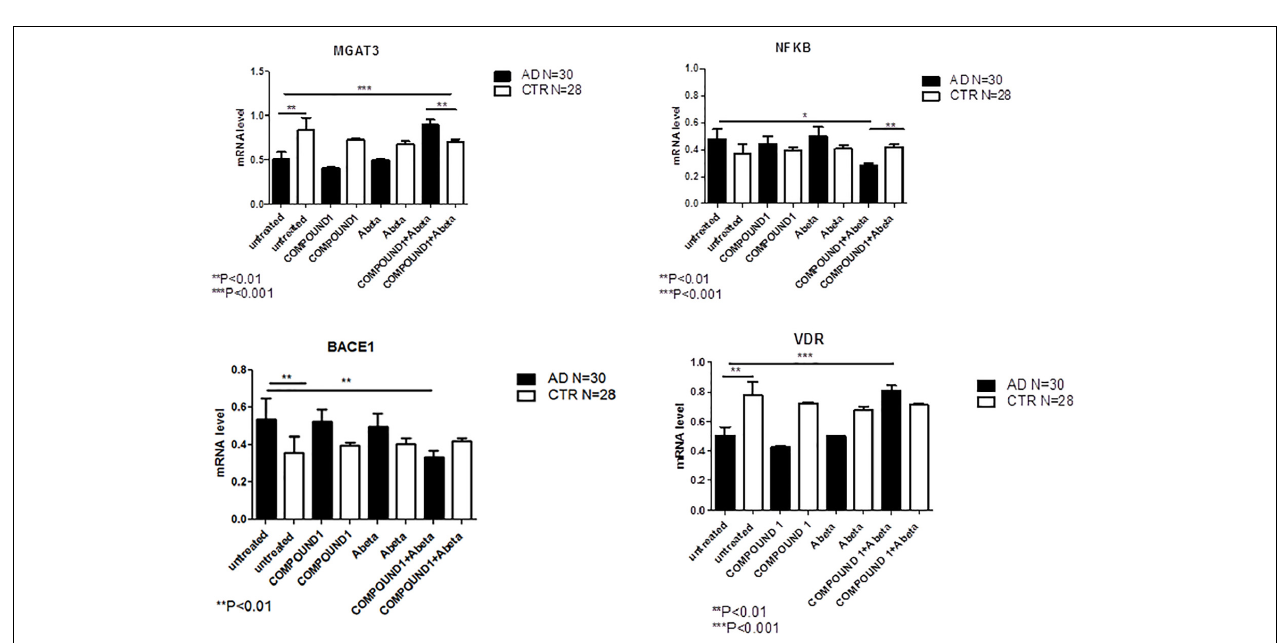
FIGURE 5 | Peripheral blood mononuclear cells from AD patients and control subjects treated with A β (48 h) or untreated, COMPOUND 1 (24 h) and COMPOUND 1 (24 h) + A β (24 h). (A) Immunohistochemistry images; (B) A β Alpha Technology Assays; (C) Deregulated RNAs for PBMCs treated with A β and treated with COMPOUND 1 + A β .